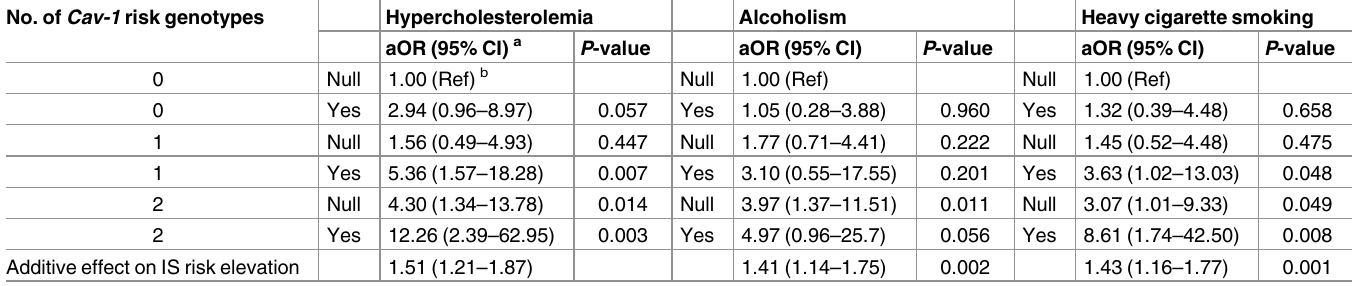
Table 5. Risk elevation of an LAA stroke in individuals with the eNOS 894Asp variant genotype in combination with Cav-1 polymorphisms strati- fied by hypercholesterolemia, alcoholism, or heavy cigarette